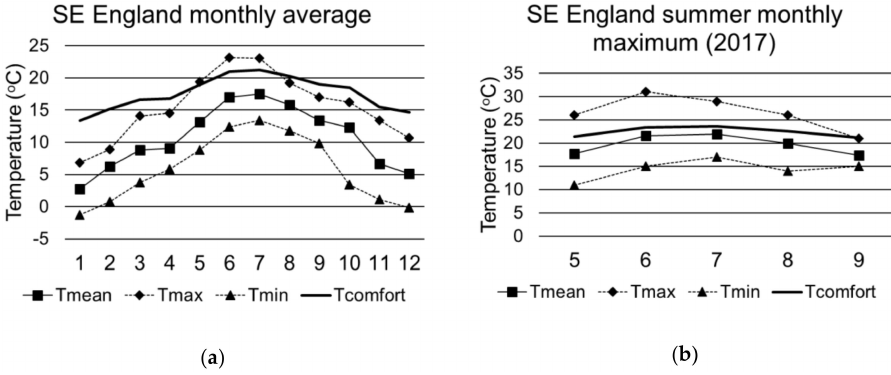
Figure 3. ( a ) Monthly average temperature for case study location; ( b ) Summer (2017) monthly maximum temperatures for case study location.